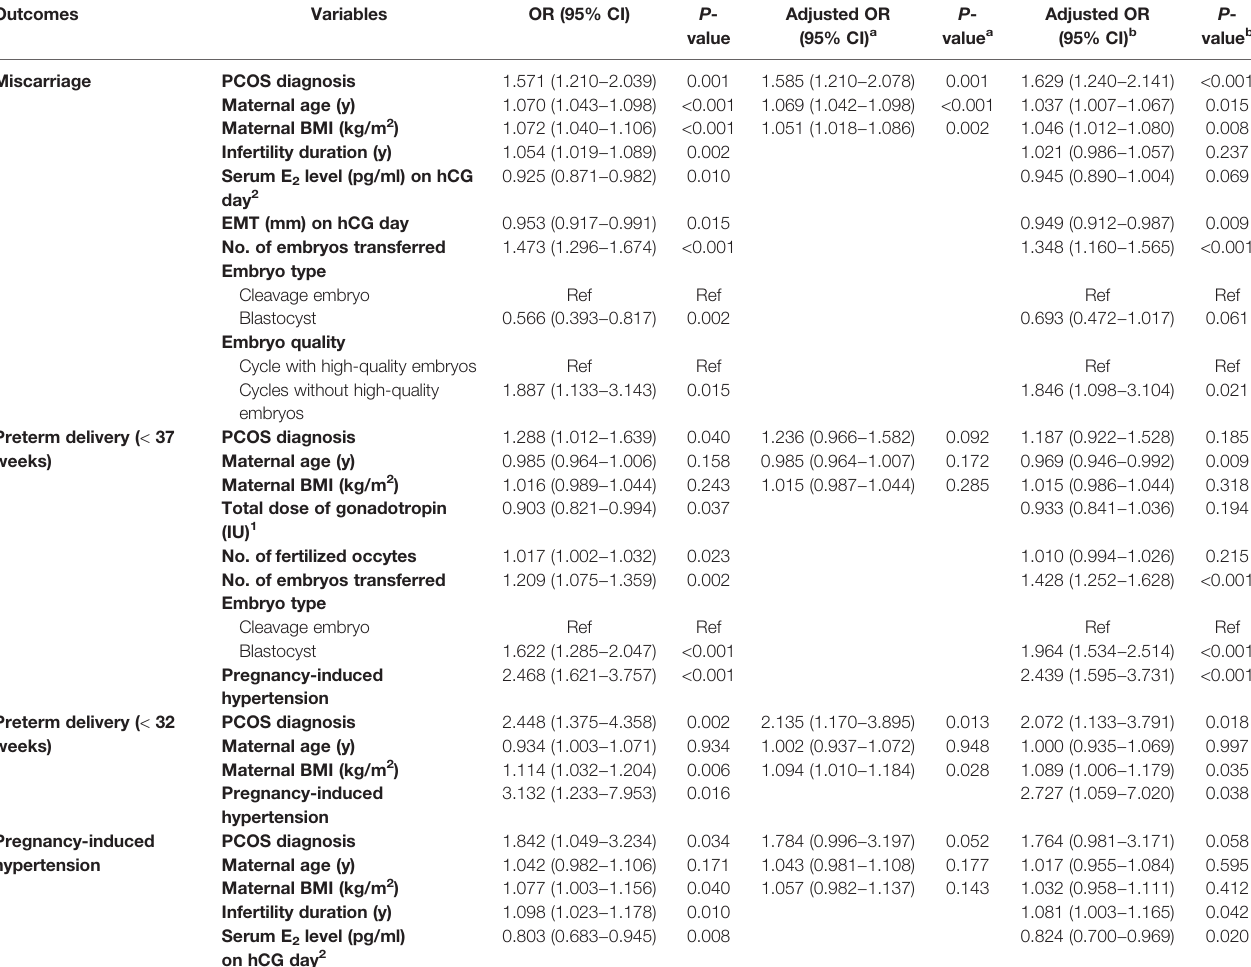
TABLE 4 | Univariable and multivariable regression analysis of risk of miscarriage, preterm delivery and pregnancy-induced hypertension.